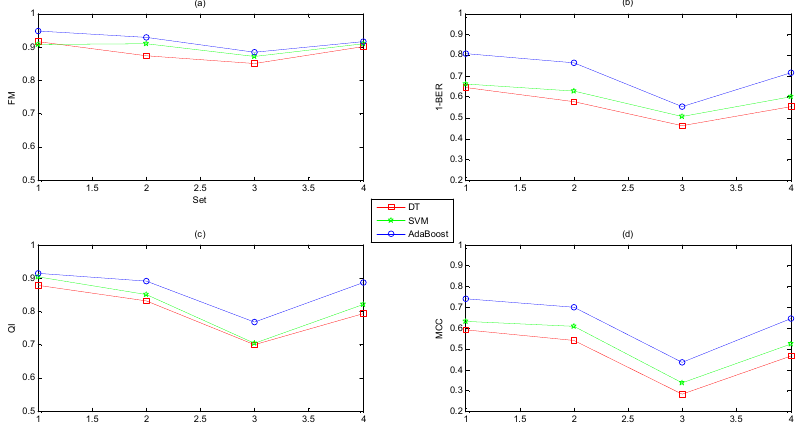
Figure 9. Comparison of the averaged performance evaluation indicators using different datasets obtained from ST, AUC and PCA based on three classifiers across ten folds. The x‐axis shows Set_A, Set_B, Set_C, and Set_Complete.